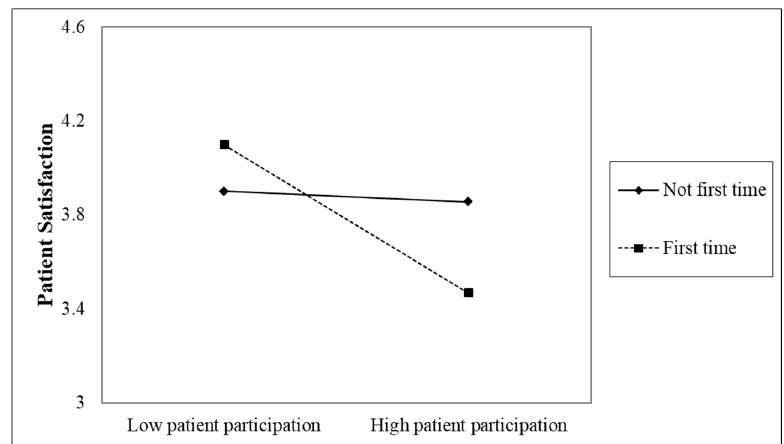
Figure 1. Simple slopes for the interaction between patient participation and first inpatient stay on patient satisfaction.